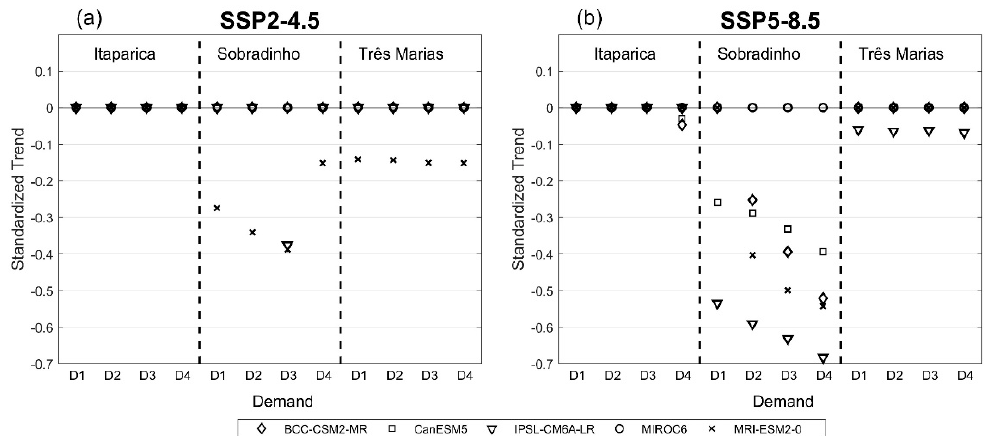
Figure 16. Trend, according to the Mann–Kendall Sen method of the standardized annual energy hydropower, referring to the: ( a ) SSP2-4.5 and ( b ) SSP5-8.5 Scenarios of the CMIP6 for the period 2021–2050. D1, D2, D3 and D4 are projections of consumptive demands.